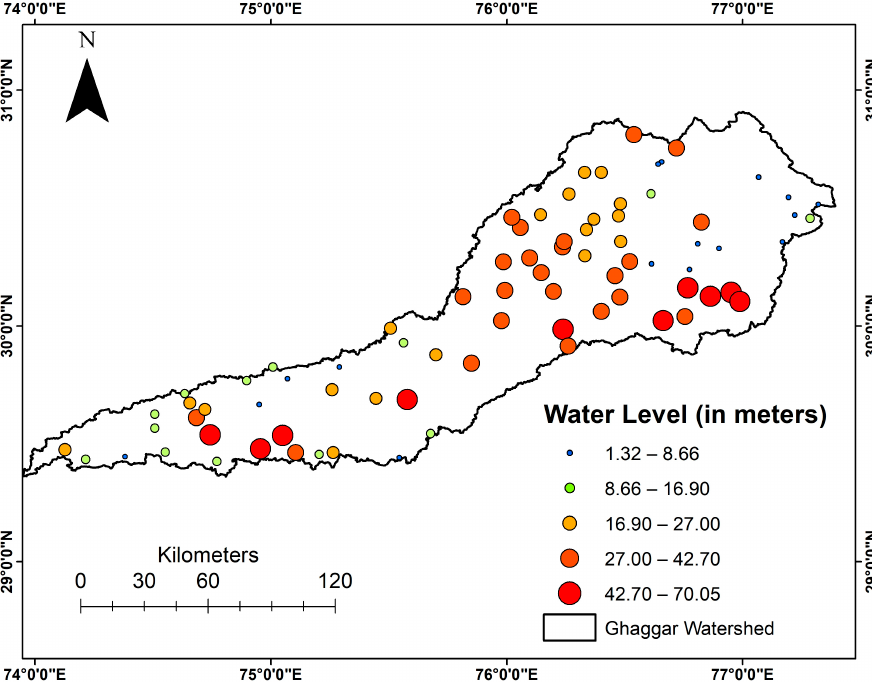
Figure 15. Pie chart showing groundwater potential in the study region. Table 8. Pixel-based analysis for ground water potential (30 m).